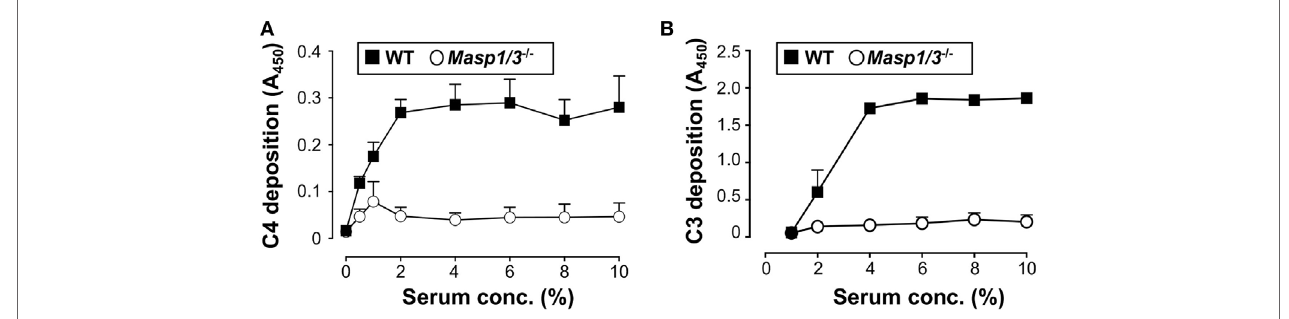
FigUre 1 | Inability of the lectin pathway (a) and alternative pathway (B) activation in sera from 10- to 14-week-old Masp1/3 − / − MRL/ lpr mice. Values are means ± SD ( n =